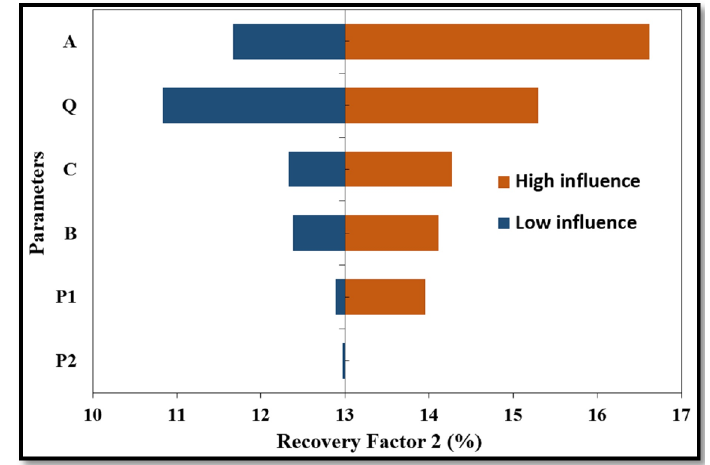
Figure 8. Results of sensitivity analysis of single parameters on the effect on recovery factor 2 (RF 2 ).